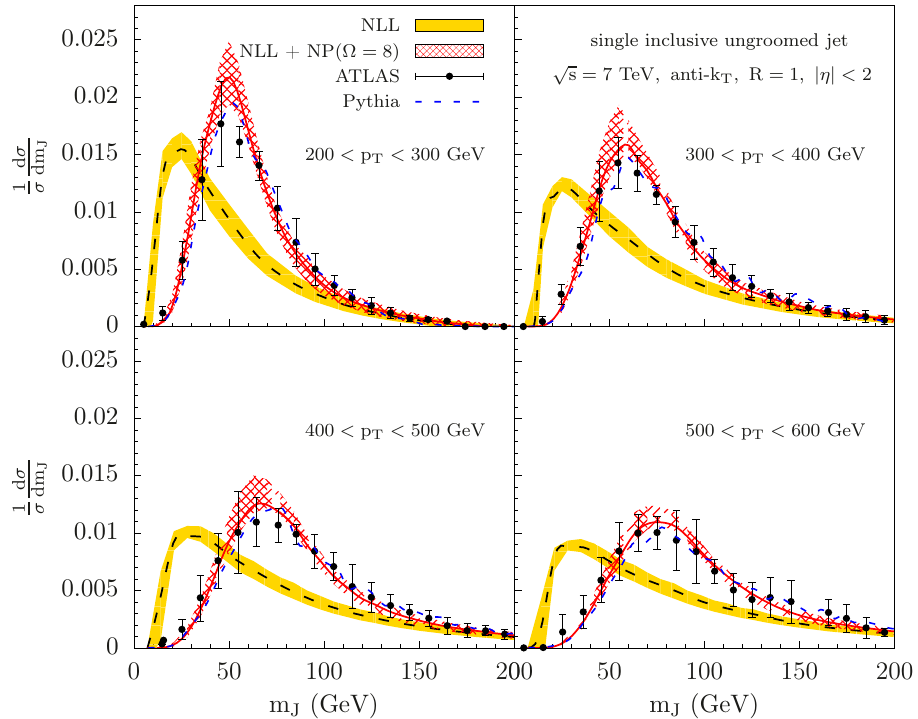
Figure 4 . Comparison of our theoretical calculations and the experimental data from the ATLAS collaboration [15] taken at p s = 7 TeV. The dashed black lines and the yellow error bands show the purely perturbative results at NLL accuracy. The red lines and the red hatched error bands show the theoretical results when the non-perturbative shape function is included. The parameter of the non- perturbative shape function is chosen as (cid:10) = 8 GeV, see eq. (4.4), and the distribution shown in red is obtained following eq. (4.7). The dashed blue lines are the results from Pythia8 simulations [94]. The jet rapidity is integrated over (cid:17) < 2, and the observed jet transverse momentum is separated j j into four di(cid:11)erent intervals 200 < p T < 300 GeV, 300 < p T < 400 GeV, 400 < p T < 500 GeV, 500 < p T < 600 GeV which correspond to the four di(cid:11)erent